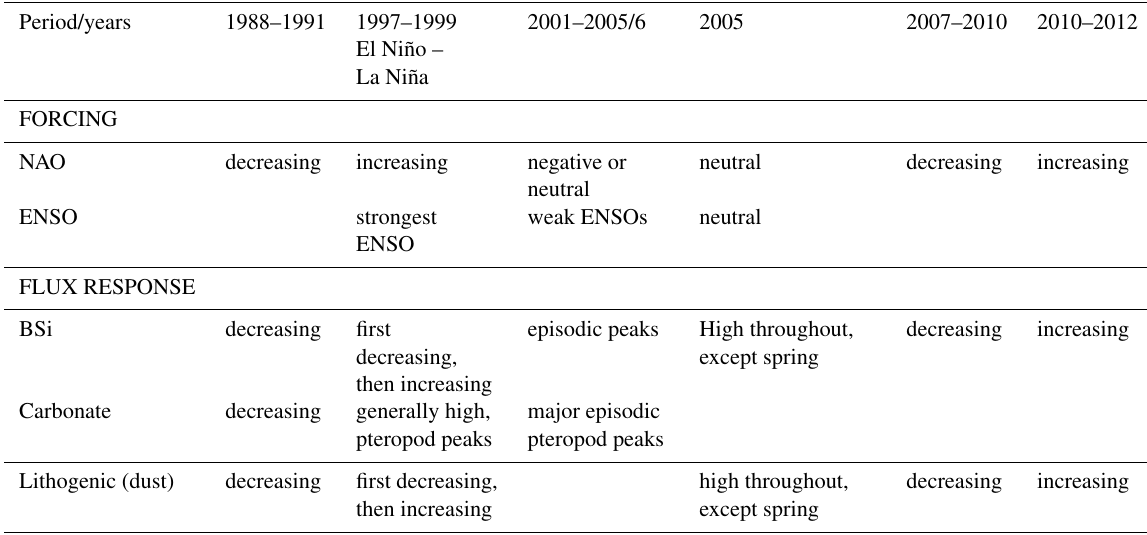
Table 4. Summary of important flux changes between 1988 and 2012 which are related to large-scale climate modes such as NAO and ENSO. The record is divided into six major periods, including the outstanding year 2005 (see